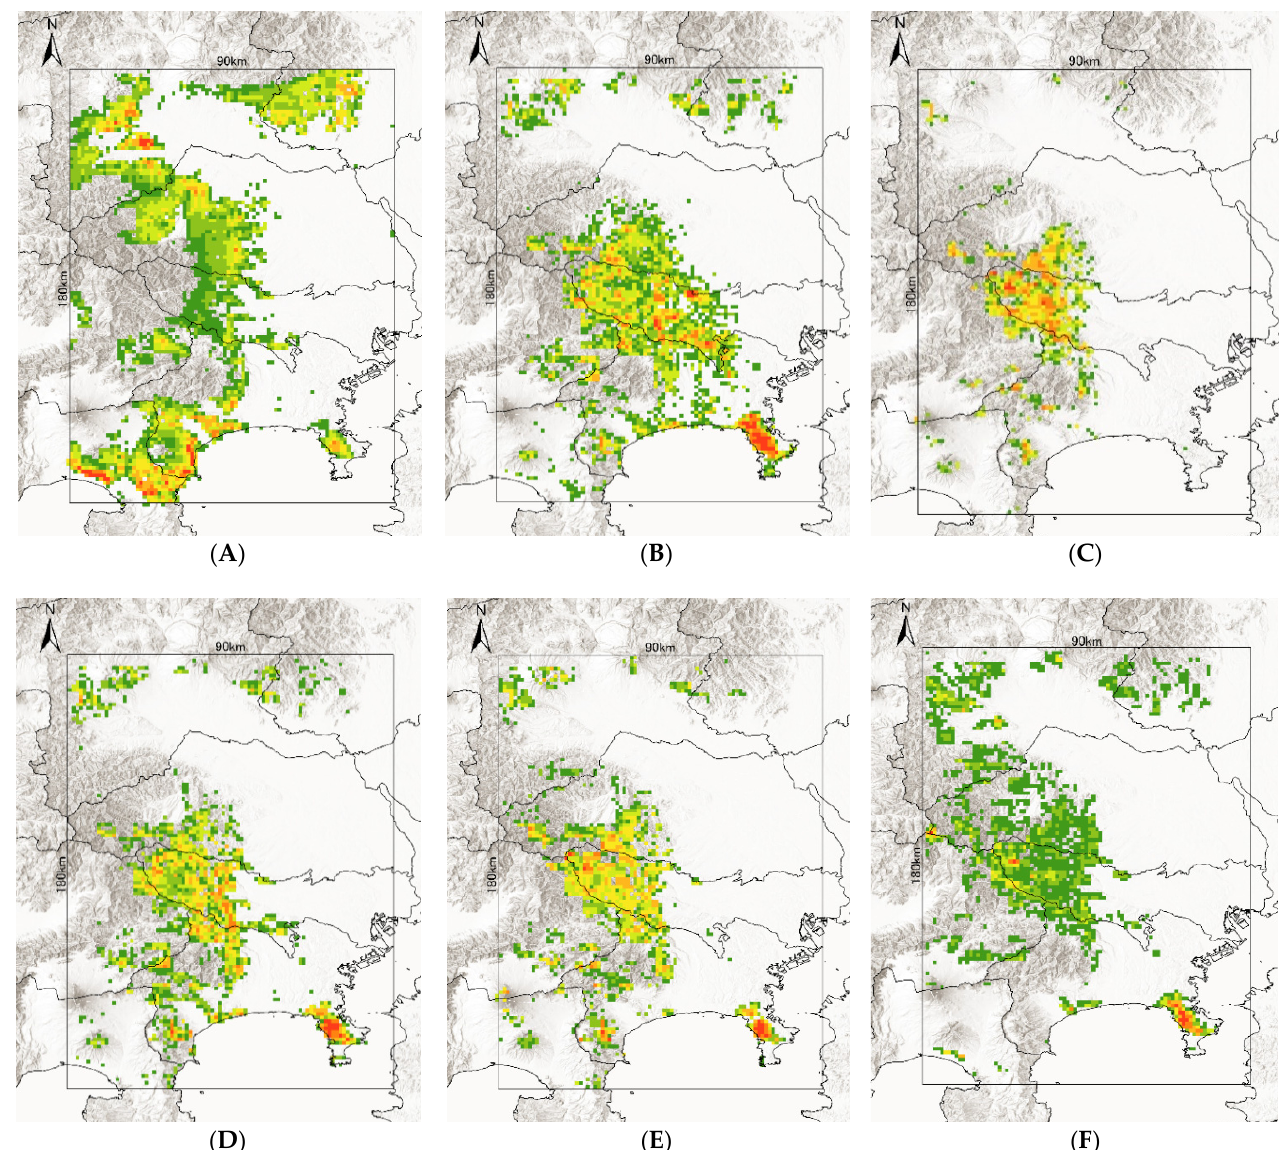
Figure 3. Potential distribution maps of A. testudinarium ( A ), H. flava ( B ), H. kitaokai ( C ), H. longicornis ( D ), H. megaspinosa ( E ), and I. ovatus ( F ). Red indicates a more suitable environment, and green indicates a less suitable environment for tick